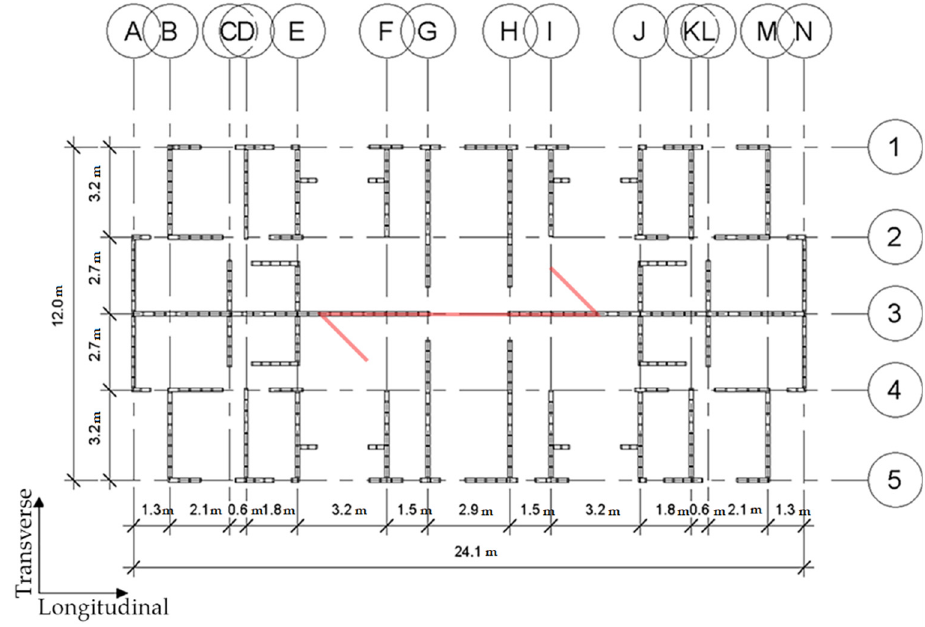
Figure 1. Plan view of the studied archetype. The red arrow represents the orientation of the load transfer direction of the one-way floor system.